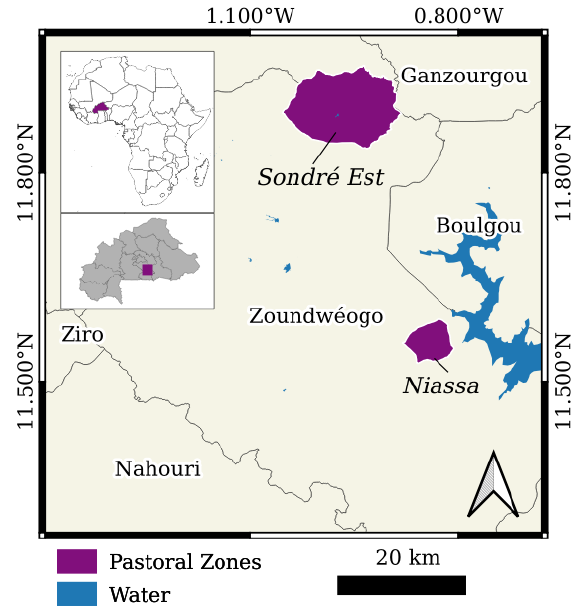
Figure 1: Location of the the pastoral zones studied,